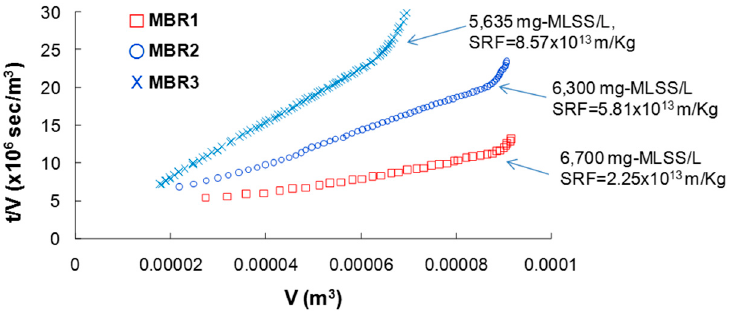
Figure 6. Plot of the time to permeate volume (t/V) versus the permeate volume cumulative (V) and calculated specific resistance of filtration (SRF).